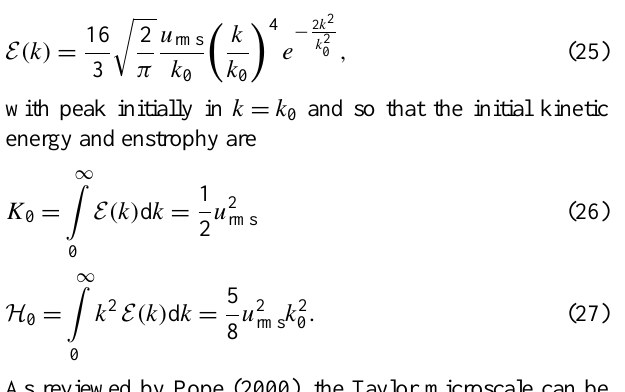
Figure 1. ASHEE parallel efficiency on Fermi and PLX supercom- puters at CINECA